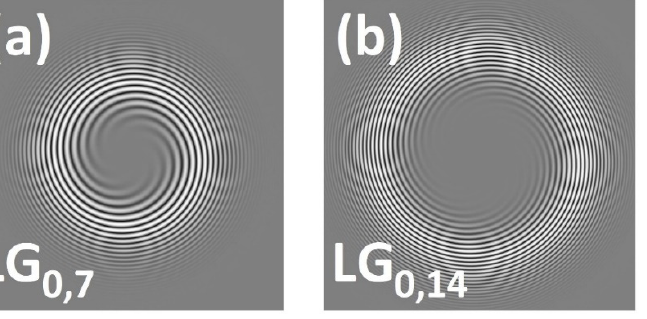
Figure 9. Enlarged views of the interference patterns marked in red dotted line in Figure 8, ( a ) LG 0,17 and ( b ) LG 0,14 .